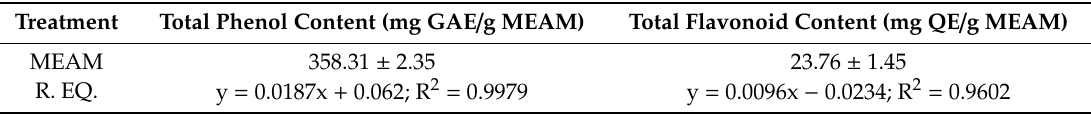
Table 2. Quantitative analysis of antioxidant relevant phytochemicals containing total phenol content and total flavonoid content of MEAM